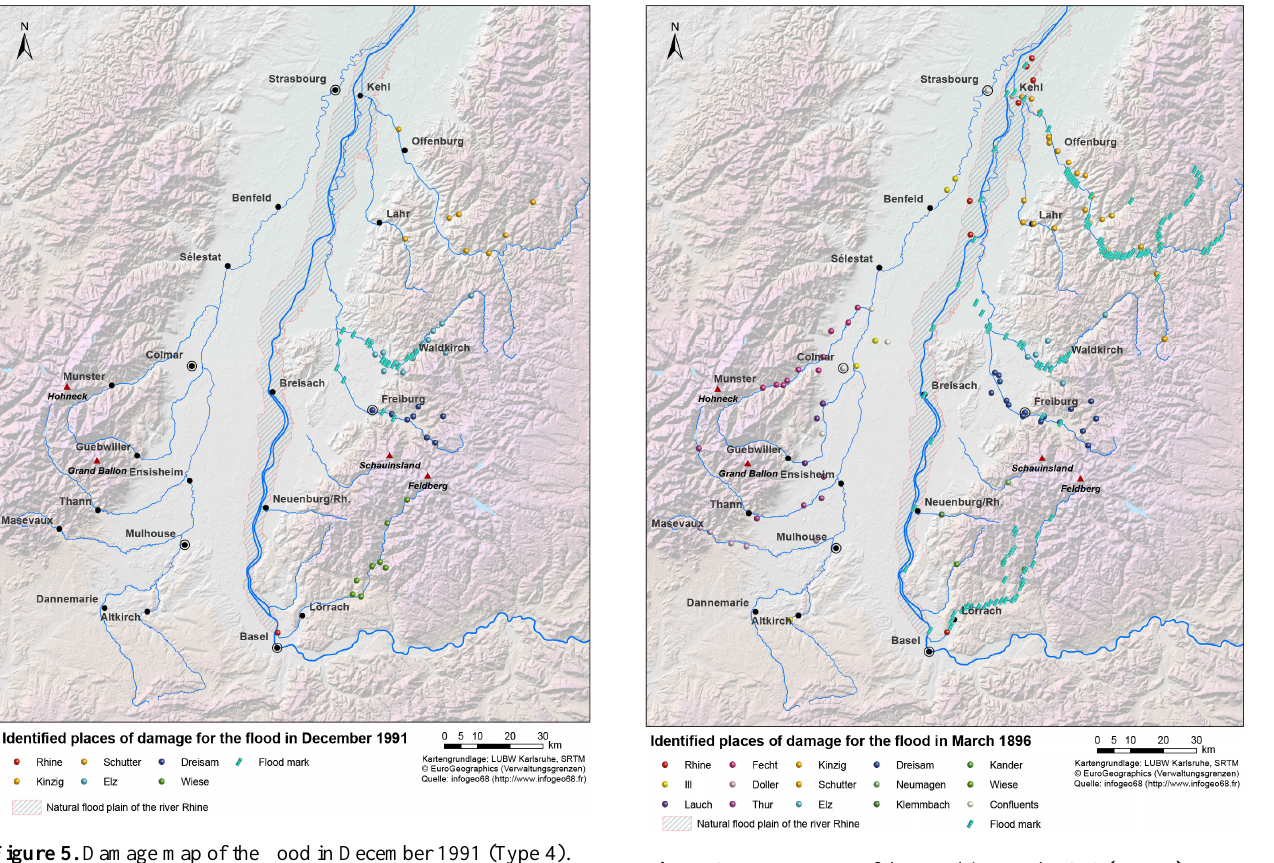
Figure 6. Damage map of the flood in March 1896 (Type